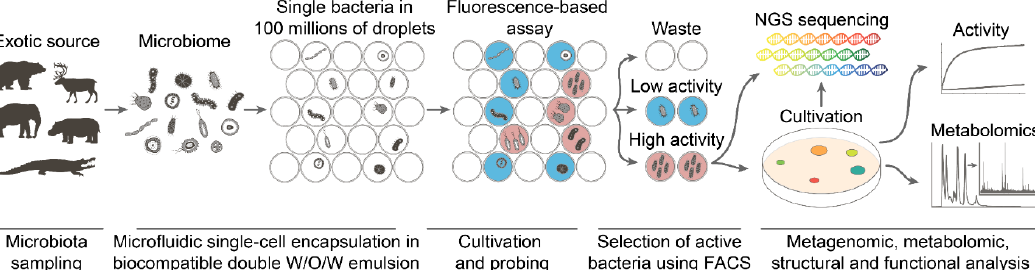
Figure 1. Pipeline of deep functional microbiome profiling. An exotic microbiota undergoes single-cell encapsulation in droplets of a biocompatible microfluidic double emulsion with the respective fluorogenic reporters. A fluorescence-based assay enables probing of the biological or biochemical activity of the encapsulated microorganisms. FACS-based screening classifies the microbiome based on the phenotype assayed. The selected subpopulations are analyzed subsequently by a combination of omics technologies for a detailed characterization of their phenotypes. NGS: Next Generation Sequencing.